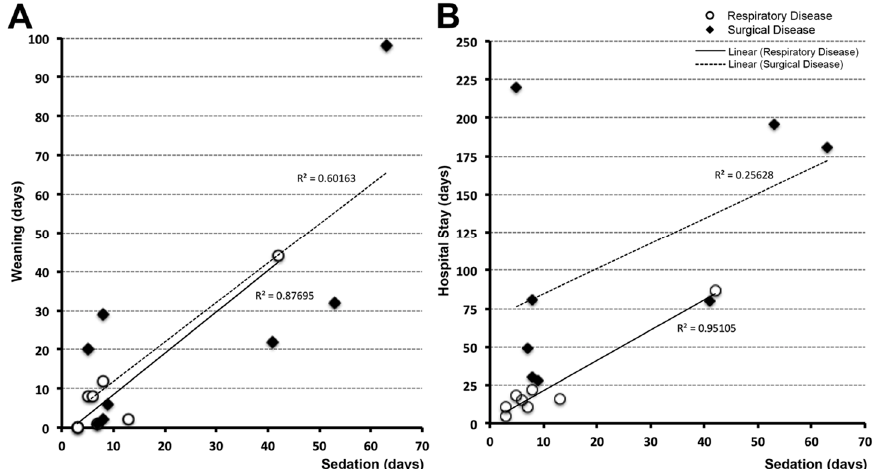
Figure 4. Correlation of length of sedation with length of weaning and hospital stay. Panel ( A ) demonstrates linear correlation between length of weaning (days) and length of sedation (days) for respiratory ( n = 8; white circles) and surgical ( n = 8; black diamonds) disease groups. In other words, longer periods of sedation were associated with increased length of weaning, irrespective of disease (respiratory ( r 2 = 0.88, p < 0.01); surgical ( r 2 = 0.60, p = 0.01)). Panel ( B) demonstrates linear correlation between length of sedation and length of hospital stay for the respiratory disease group ( r 2 = 0.95, p ≤ 0.01), but not the surgical group ( r 2 = 0.26, p = 0.1).